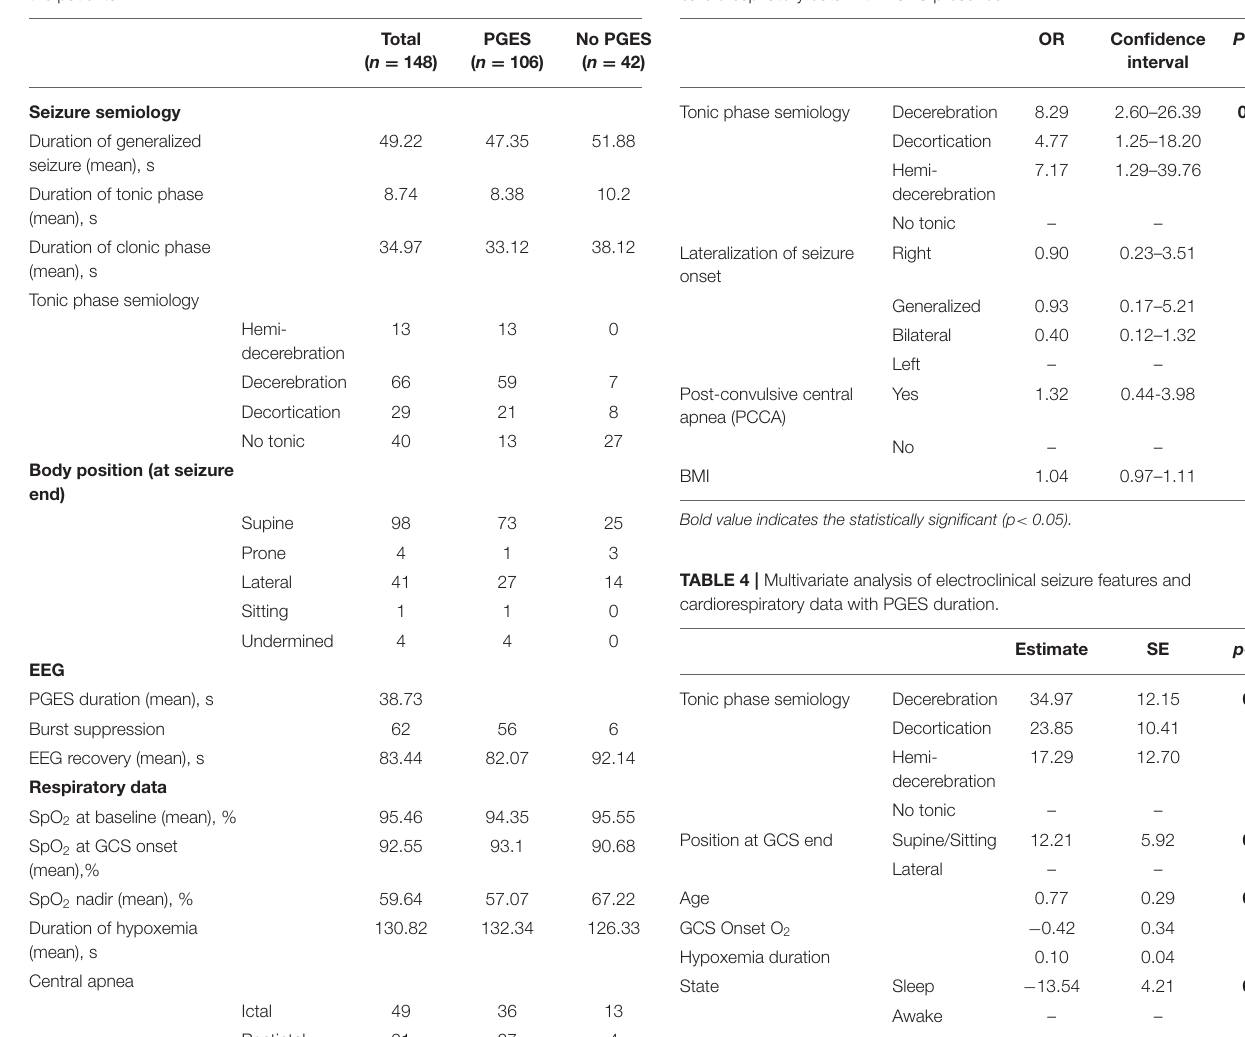
TABLE 3 | Multivariate analysis of electroclinical seizure features and cardiorespiratory data with PGES presence.